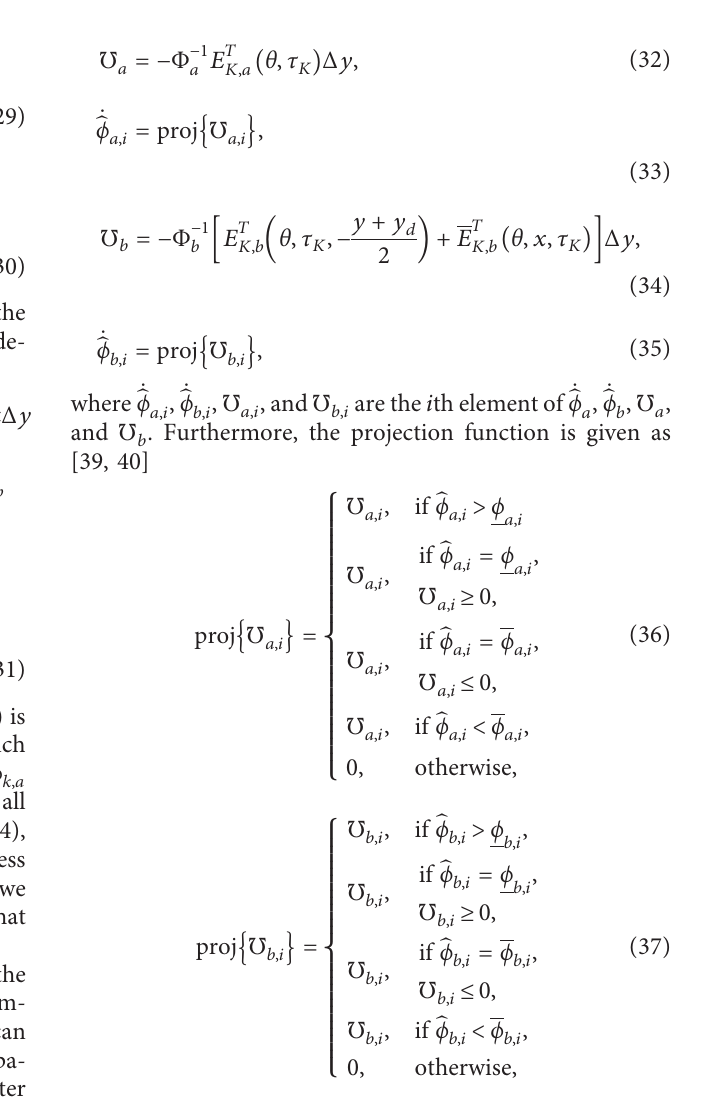
Figure 1: Visually servoed wheeled mobile robot system and coordinate